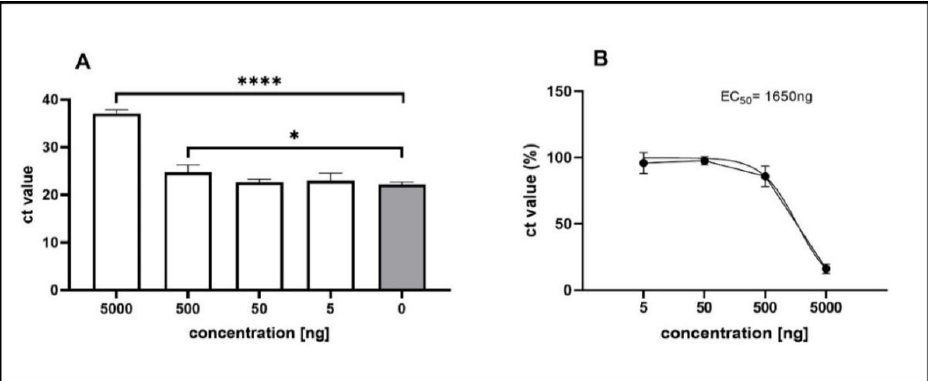
Figure 2. Feline coronavirus (FCoV) replication inhibition by Xraphconn ® . ( A ) FCoV cycle threshold (ct) values in supernatants collected from infected Crandell-Rees Feline Kidney (CRFK) cells (multiplicity of infection (MOI = 0.01) treated with the indicated active compound concentrations were collected at 24 h post infection ( n = 4). Significance levels compared to the results for untreated cells were determined by the Bonferroni’s multiple comparisons test and are indicated as follows: *, p ≤ 0.05; ****, p < 0.0001. ( B ) Data from four biological replicates were used to calculate the half maximal effective concentration (EC 50 ) value by non-linear regression analysis.